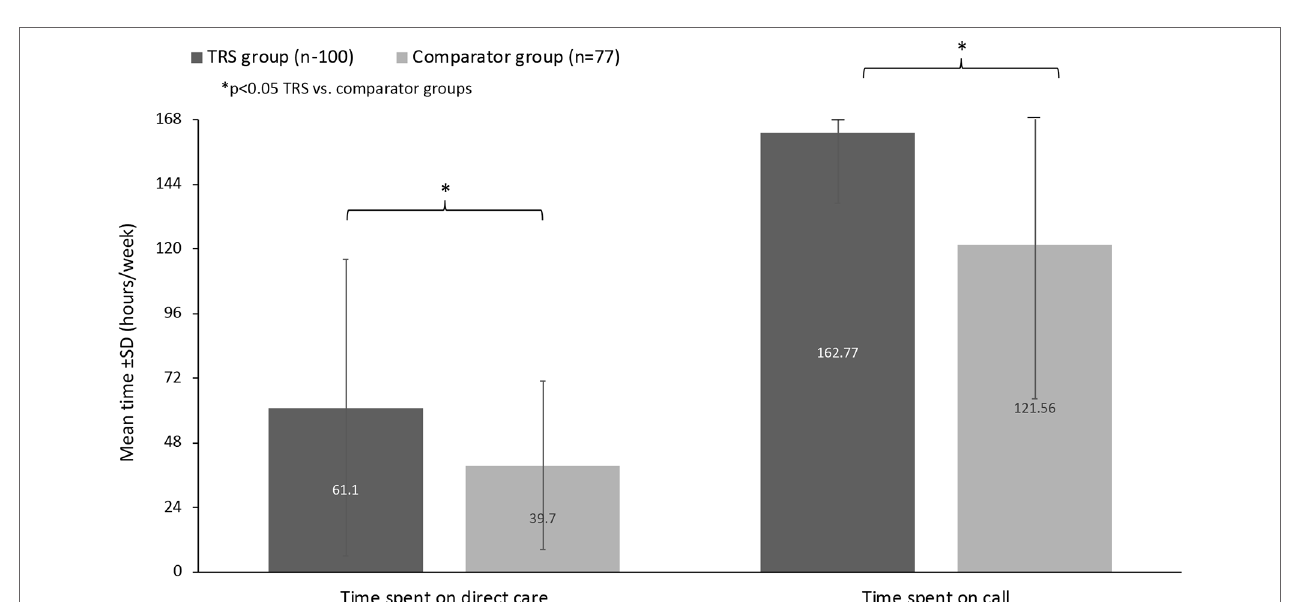
FIGURE 2 | Overall caregiver involvement in daily